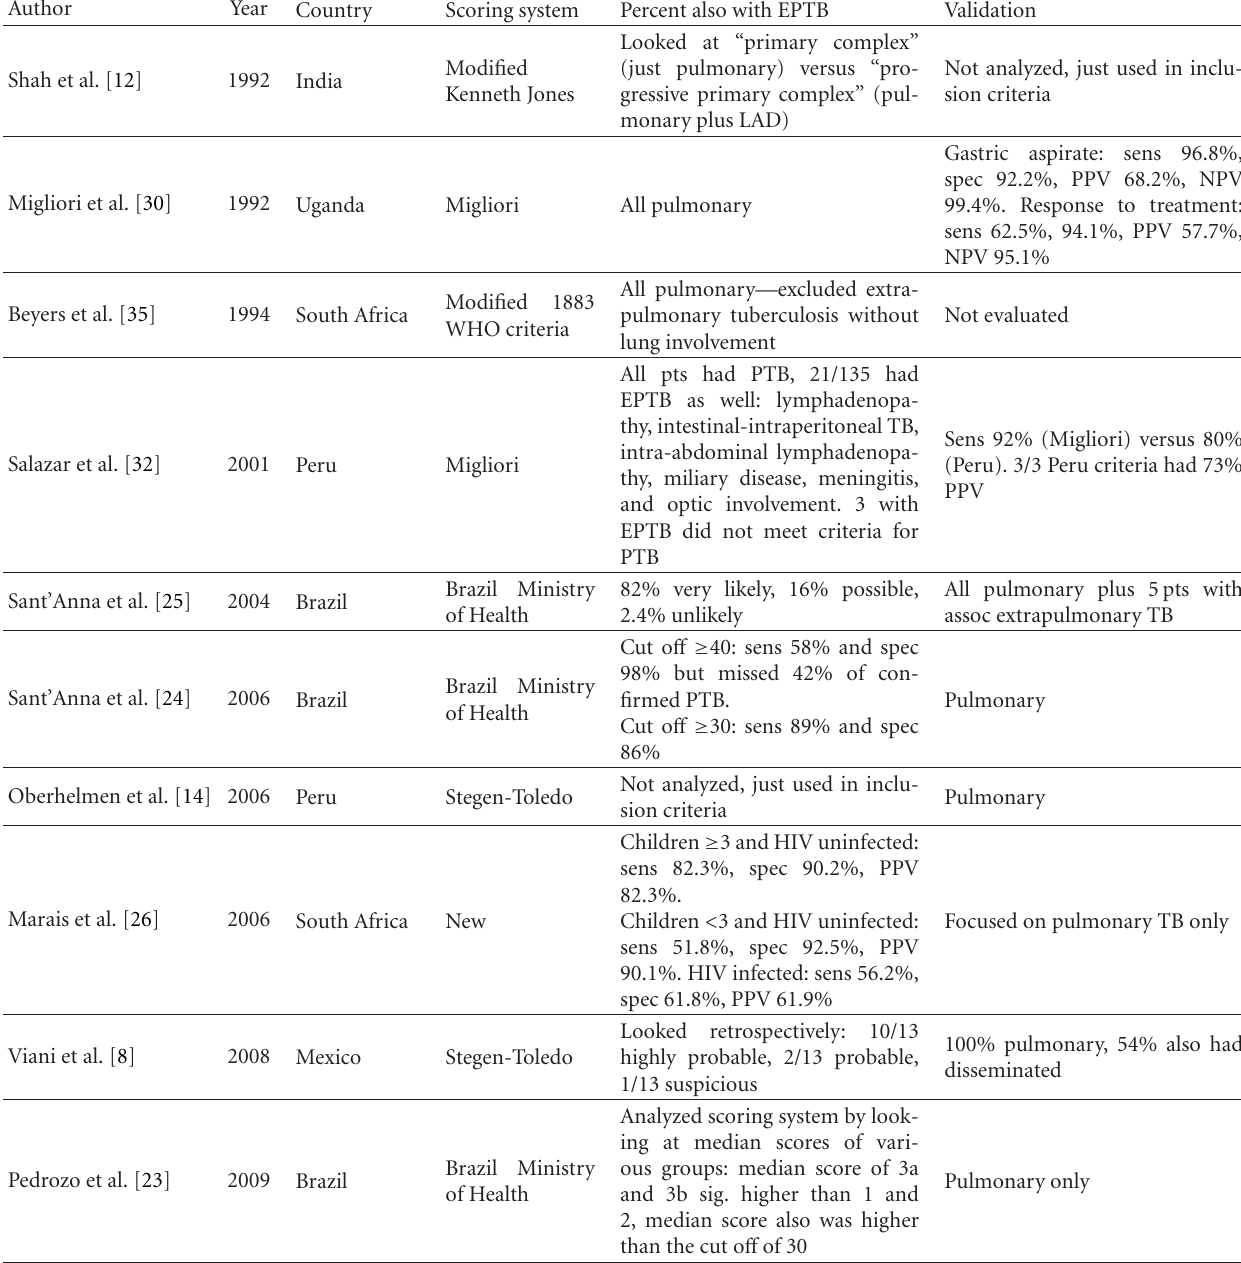
Table 5: Studies focusing primarily on pulmonary